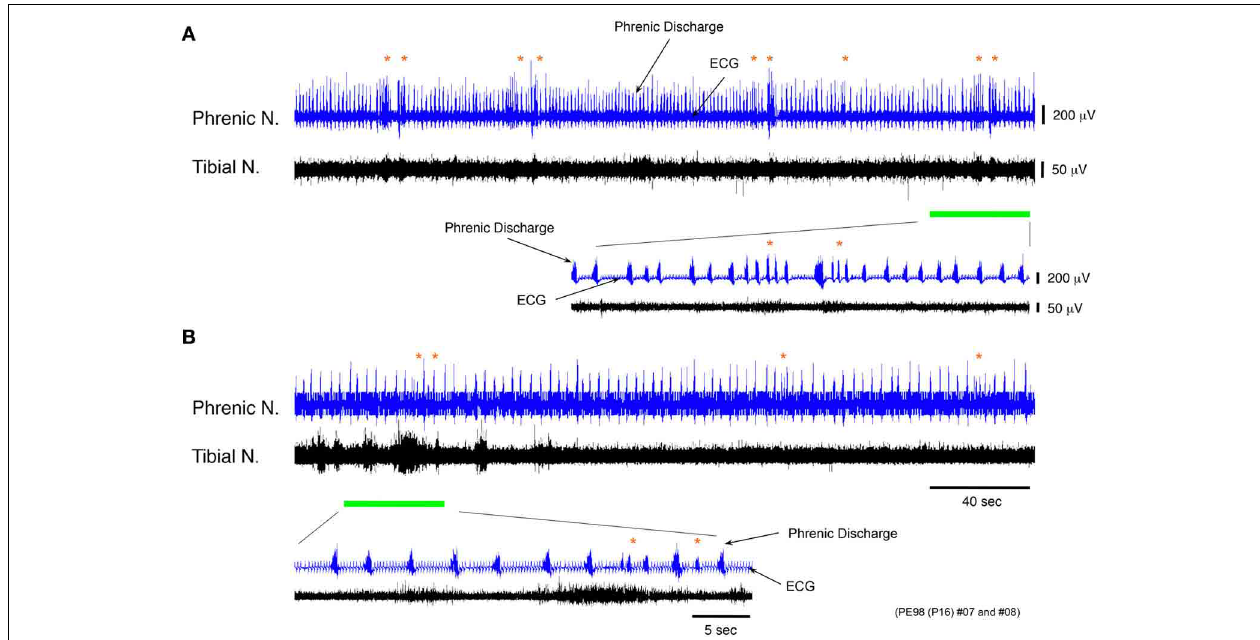
FIGURE 7 | Recordings of experimental trials showing changing incidence of phrenic discharge episodes before and after spinalization. (A,B) Recordings showing phrenic and tibial nerve discharge induced before and after spinalization of a decerebrate and arterially perfused in situ preparation made at postnatal day 16 at the twelfth thoracic vertebra level at